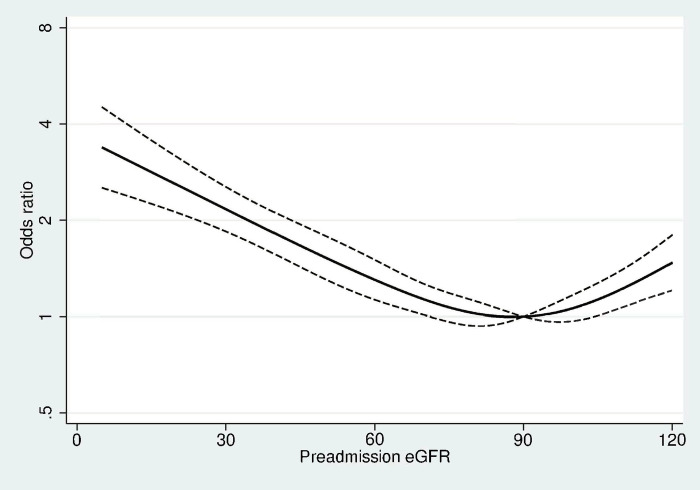
Graph of the cubic spline model relating exact estimated glomerular filtration rate (eGFR) to the fully adjusted odds ratios (95% CI) of acute kidney injury within 30 days after admission with pyelonephritis.Abbreviations: eGFR, estimated glomerular filtration rate. Adjusted for age, sex, diabetes, hypertension, heart failure, and malformation of the urinary tract. Preadmission eGFR is calculated most the most recent outpatients creatinine measurement one year to seven days before pyelonephritis admission.